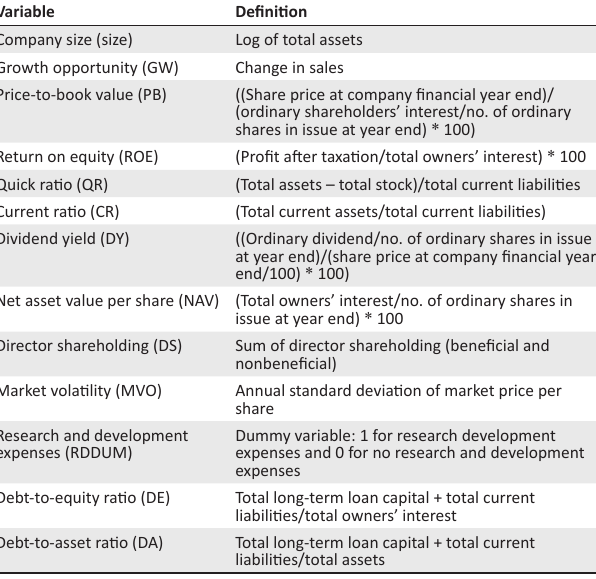
TABLE 1 : Predictors of choice